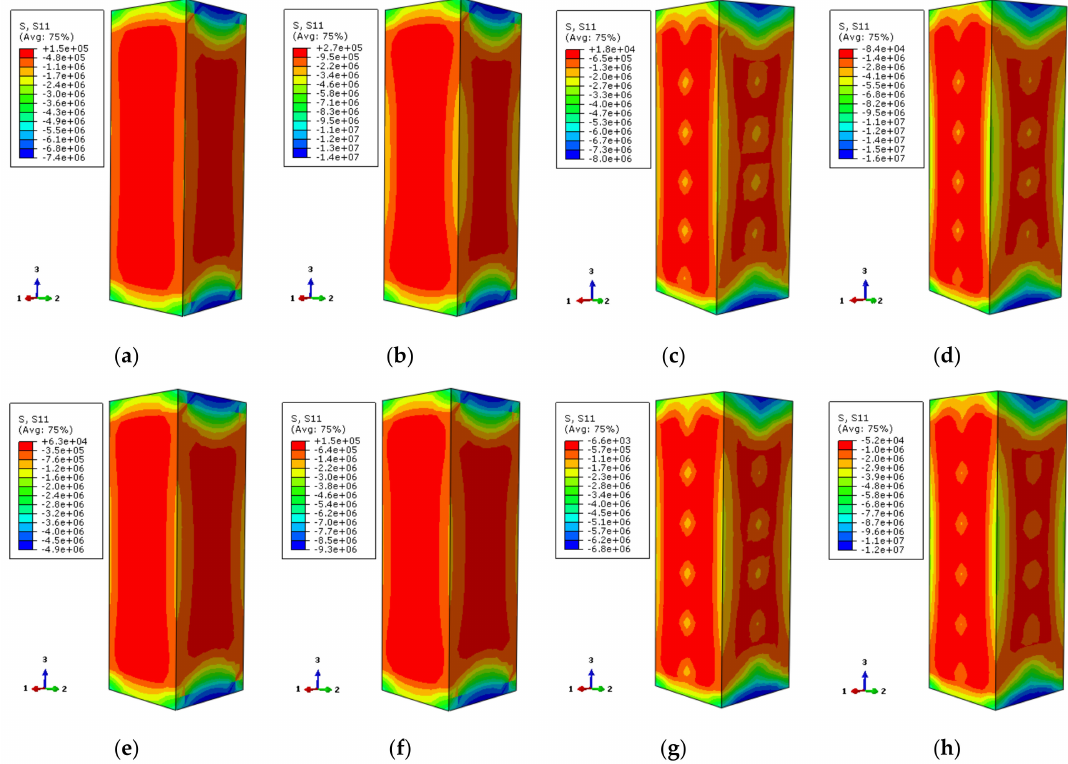
Figure 17. The lateral stress distribution of concrete ( a ) DS-200-0-0.75; ( b ) DS-200-0-1; ( c ) DS-200-0.75; ( d ) DS-200-1; ( e ) DS-600-0-0.75; ( f ) DS-600-0-1; ( g ) DS-600-0.75; ( h ) DS-600-1.